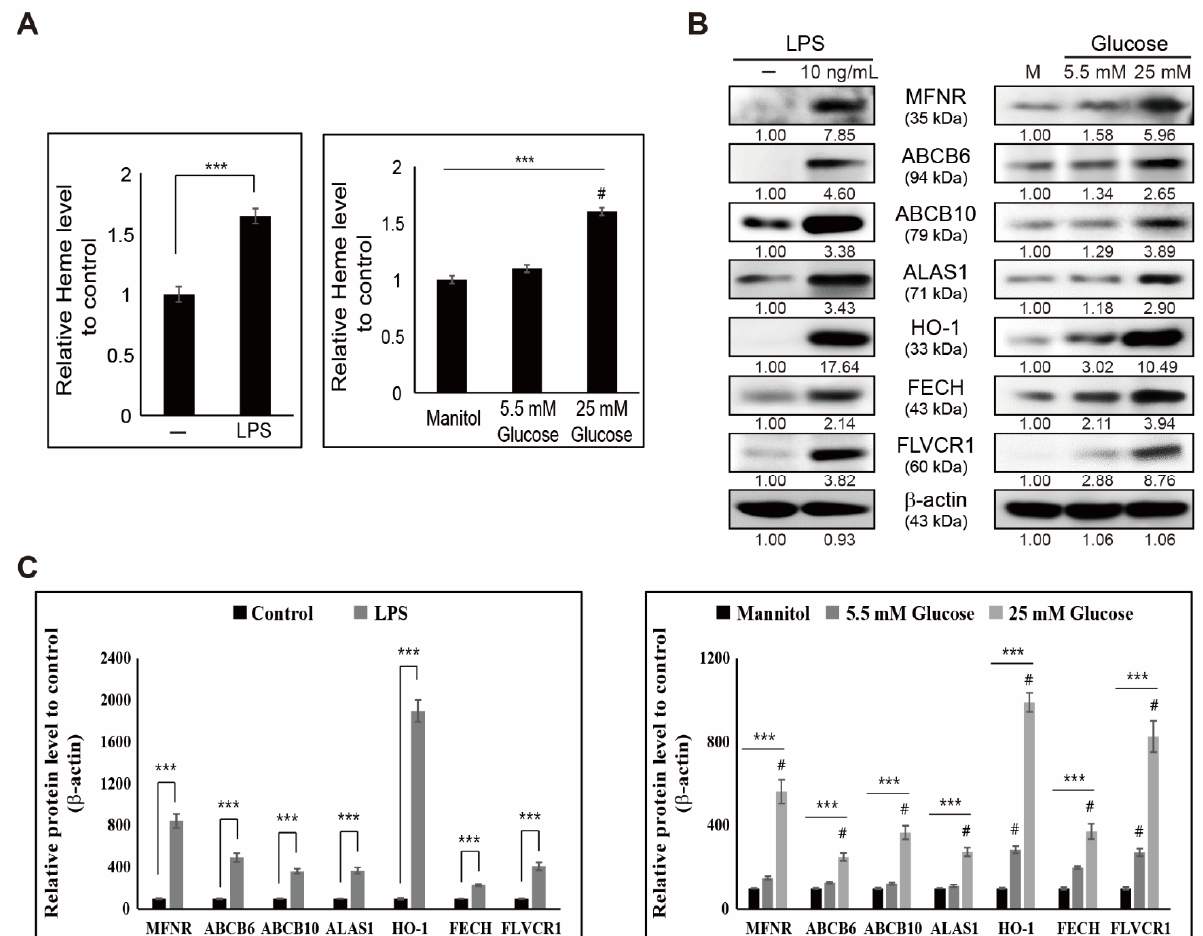
Figure 2. Heme biosynthesis occurs during inflammation. ( A ) Heme assay showing the relative heme level obtained in THP ‐ 1 cells after treatment with LPS (10 ng/mL) for 48 h and mannitol or glucose (5.5 and 25 mM) for 72 h. Data obtained after three experiments. *** p < 0.001, control vs. LPS ( t ‐ test). *** p < 0.001, mannitol vs. high glucose (ANOVA test). # The mean difference is significant at the 0.001 level. ( B ) Western blotting of MFRN, ABCB6, ABCB10, ALAS1, HO ‐ 1, FECH, and FLVCR1 proteins in THP ‐ 1 cells after treatment with LPS (10 ng/mL) for 48 h and mannitol or glucose (5.5 and 25 mM) for 72 h. Expression levels were estimated by densitometry and normalized to β‐ actin. Data were repeated thrice for confirmation. ( C ) Graphical representation of MFRN, ABCB6, ABCB10, ALAS1, HO ‐ 1, FECH, and FLVCR1 proteins in THP ‐ 1 cells after treatment with LPS (10 ng/mL) for 48 h. *** p < 0.001 ( t ‐ test). Representative expression of proteins in THP ‐ 1 cells after treatment with mannitol or glucose (5.5 and 25 mM) for 72 h. All data were repeated three times for confirmation. *** p < 0.001 (ANOVA test). # p < 0.001 vs. control. 3.3. Heme Biosynthesis Induces Inflammatory Responses through TLR4/NF ‐κ B Signaling in THP ‐ 1 Cells Based on our findings, we observed the role of iron/heme metabolism in inflamma ‐ tion. Here, we analyzed whether these metabolisms could enhance inflammatory re ‐ sponses through the inflammation pathway. First, we treated THP ‐ 1 cells with 10 μ M heme and LPS or high glucose and then analyzed the proteins by Western blotting (Figure 3A). The results obtained suggested an increase in the expression levels of receptor protein TLR4, key inflammatory response protein NF ‐κ B, and pro ‐ inflammatory cytokines IL ‐ 6, IL ‐ 1 β , and TNF ‐α upon treatment with LPS or high glucose (Figure 3B). Treatment with heme further significantly elevated the expression of these inflammatory response path ‐ ways, suggesting the role of heme biosynthesis in the inflammatory response. To confirm this, we used 5 ‐ aminolevulinic acid (ALA) for the treatment in THP ‐ 1 cells (Figure 3C),